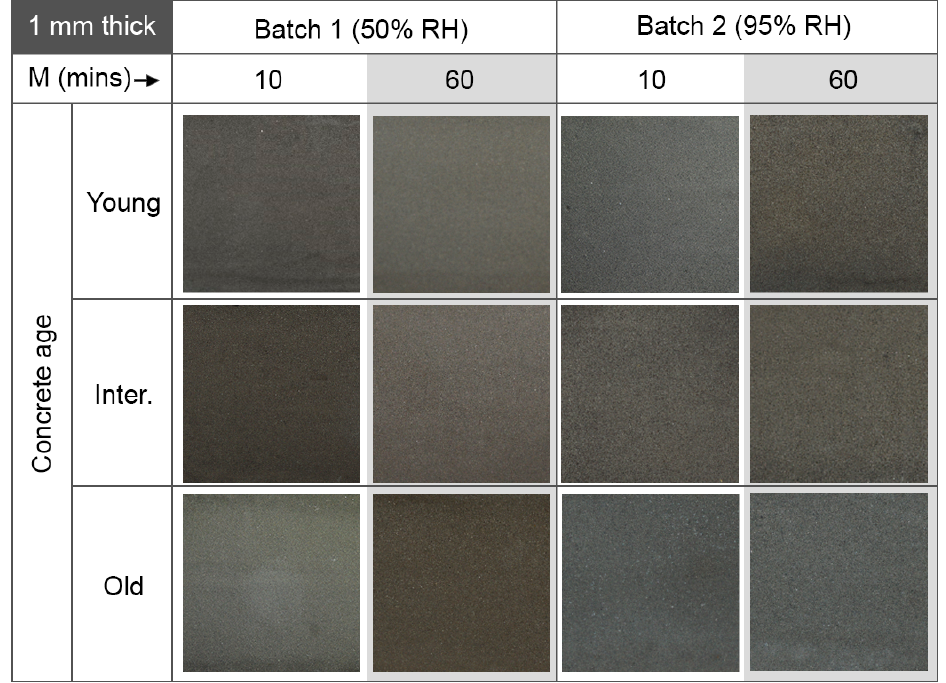
Figure 8. Images of 1 mm thick geopolymer coatings on concrete. Results are shown as a function of geopolymer mixing time, M; relative humidity (RH) during curing; and concrete substrate age. All images shown cover a 40 mm × 40 mm area on the sample. The crack quantification algorithm found negligible cracking in all samples (typically 0.001%). Materials 2018 , 11 , x FOR PEER REVIEW